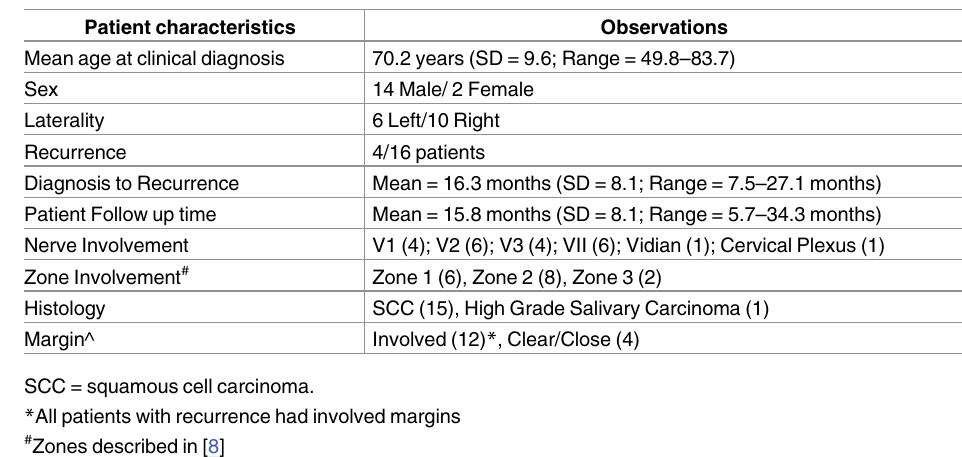
Table 1. Patient